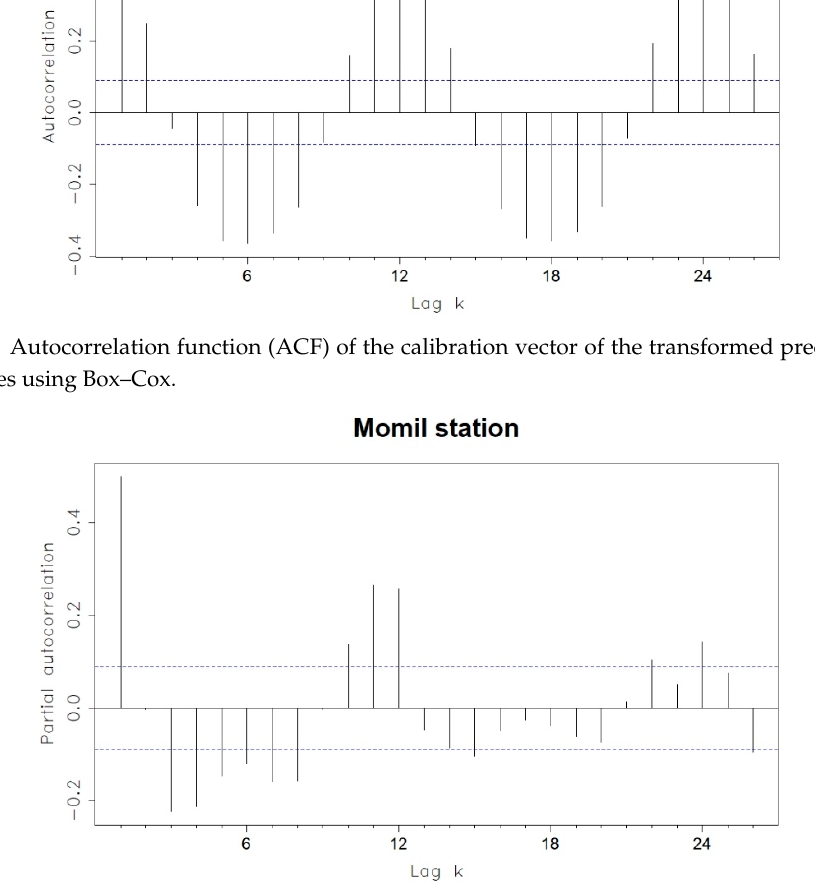
Figure 7. Partial autocorrelation function (PACF) of the calibration vector of the transformed precipitation time series using Box–Cox. Moreover, the correlograms (Figures 6 and 7) show a sinusoidal shape, which additionally suggests that the SARIMA model is the most appropriate one to represent the precipitation series of the Momil station. Thus, the different models were adjusted until the optimal one was selected using the AIC. The best fit model was SARIMA (2,0,0) × (2,1,0) 12 , which was selected based on the minimum values of AIC= 2433.6 (Table 1). The simplified general equation is: (